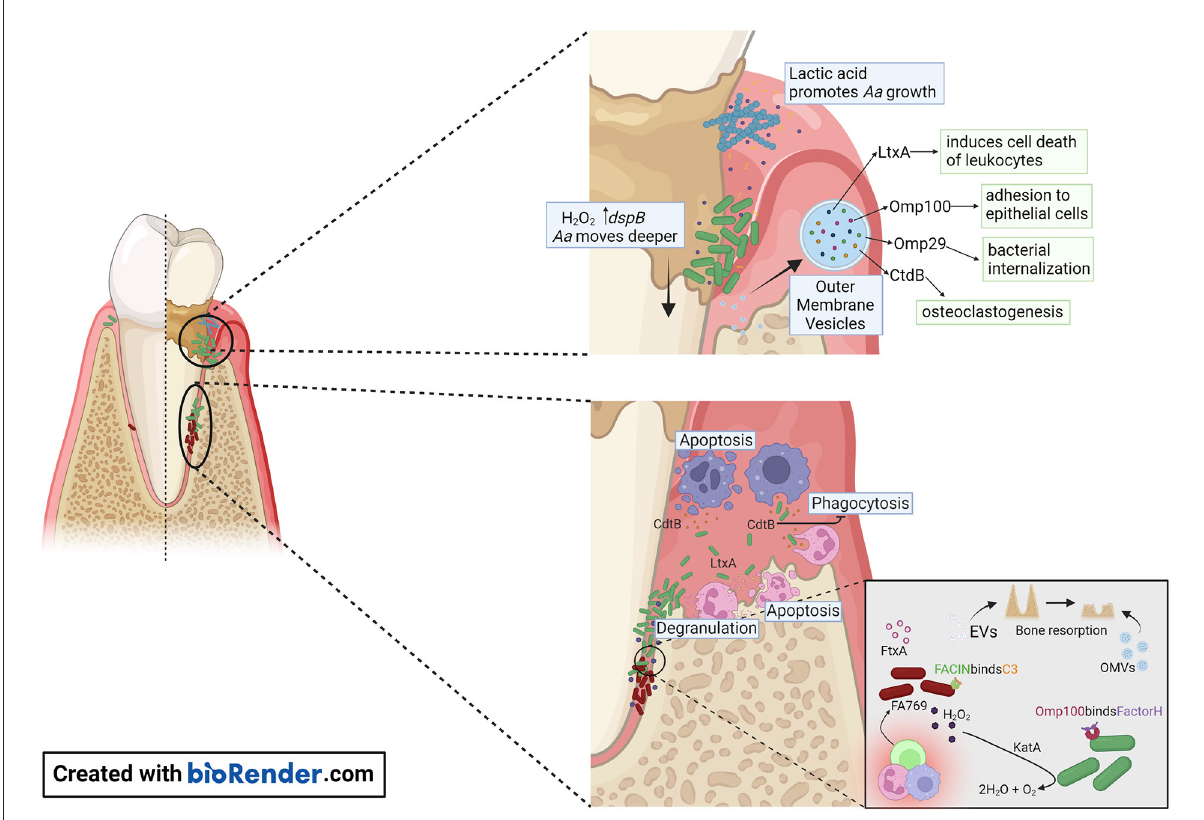
FIGURE2 Proposed model of A. actinomycetemcomitans and F. alocis interactions with the host within the gingival pocket. In the early stages of periodontitis, A. actinomycetemcomitans makes use of lactic acid produced by Streptococcus sp . as a nutrient to increase its numbers. A. actinomycetemcomitans releases OMVs that are packed with outer membrane proteins (Omp) OmpA1, Omp 100, and the virulence factors CdtB, and LtxA. Omp100 mediates initial adhesion of the bacterium, and OmpA1 binds to its putative ligand on gingival epithelial cells